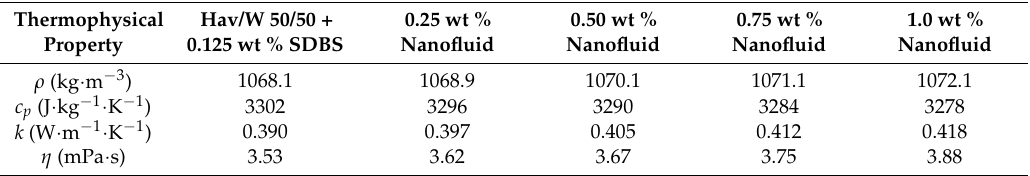
Table 1. Density ( ρ ), isobaric specific heat capacity ( c p ), thermal conductivity ( k ) and dynamic viscosity ( η ) for the different loaded (Hav/W 50/50 + 0.125 wt % SDBS) + fGnP nanofluids at 298.15 K [33]. Thermophysical